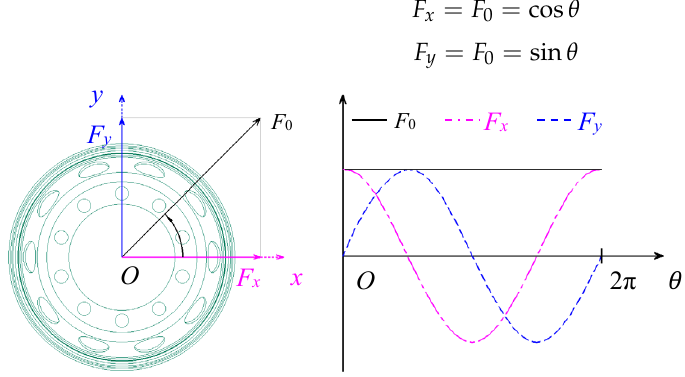
Figure 11. Load decomposition diagram.